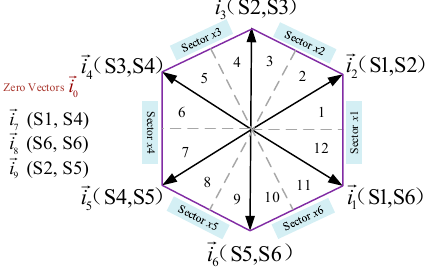
Figure 2. Space current vector diagram.